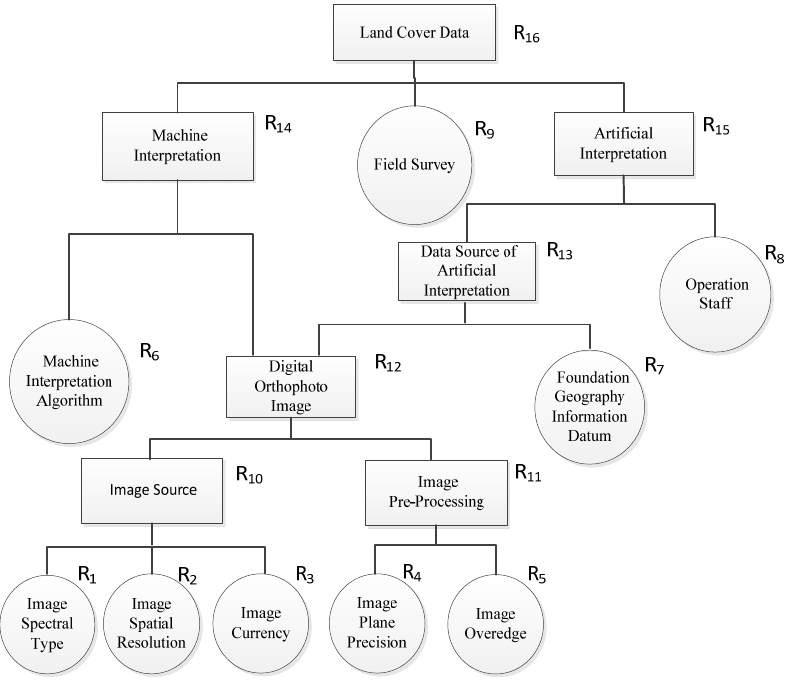
Figure 2. The process reliability analysis